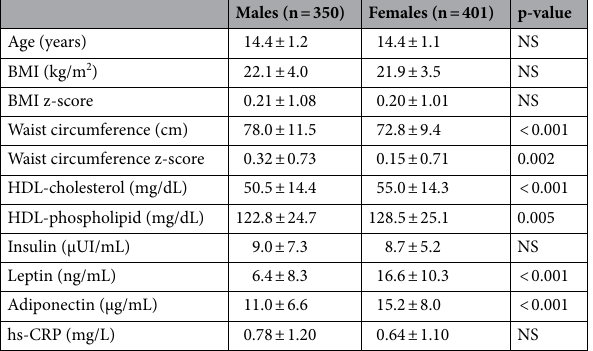
Table 1. Characteristic (mean ± SD) of the study participants. NS : non-significant.